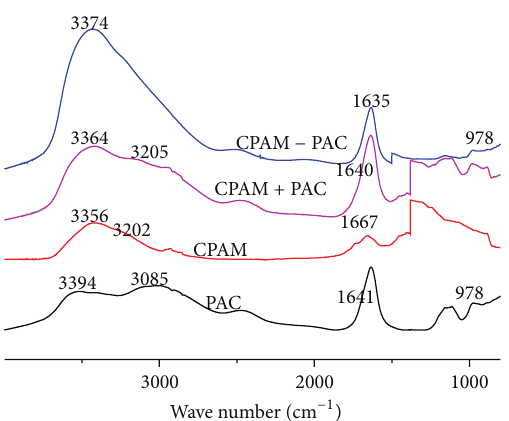
Figure 4: The FTIR of PAC after enhanced reaction of modification with cationic